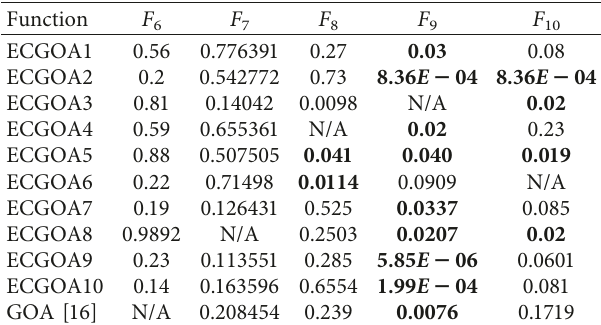
Table 8: Results of the Wilcoxon rank sum test on multimodal benchmark